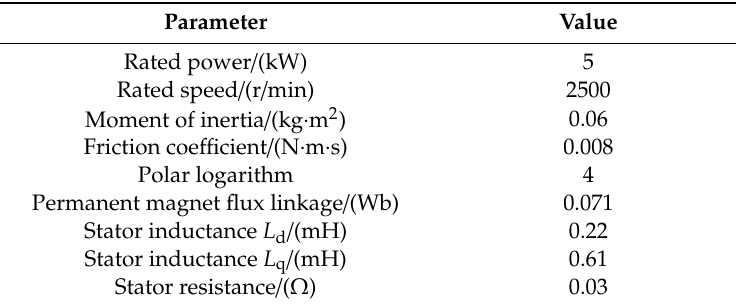
Table 1. PMSM parameters.